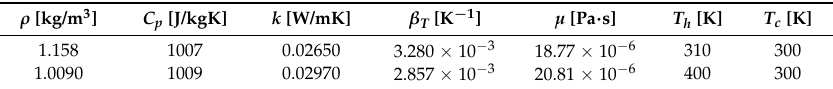
Table 2. Thermo-physical properties used in the